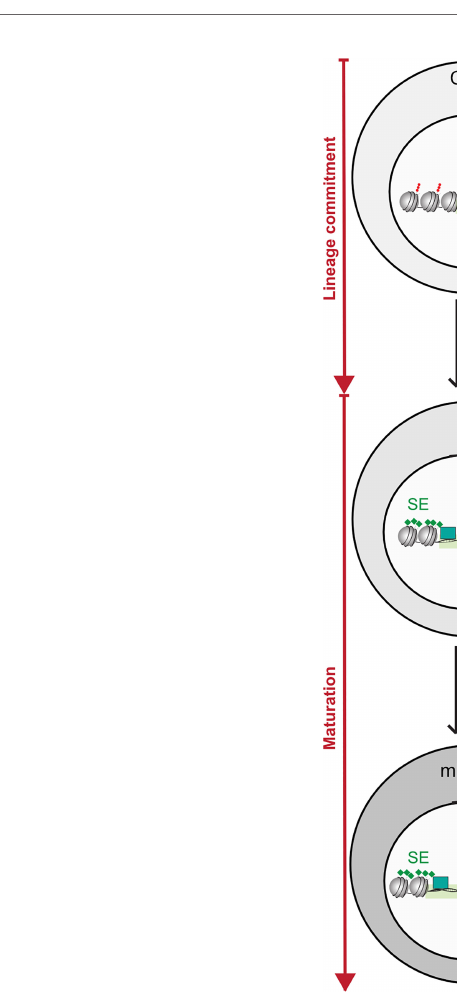
FIGURE 2 | Epigenetic regulation of NK cell lineage commitment and maturation. Lineage commitment: NK cells develop from a common lymphoid progenitor (CLP) in a multistep process, of which several steps are excluded in this schematic. During lineage commitment, NK cells were found to undergo striking changes in chromatin accessibility. Regulatory elements (RE) de fi ned by epigenetic features show a highly dynamic re-organization during lineage-commitment: the stepwise loss of progenitor signature REs on genes like PU.1 is accompanied by the acquisition of NK cell signature REs. Of these, cell-type speci fi c REs are often marked by super enhancers (SEs), which are found on genes crucial to cell identity and functionality. Areas, which display an increase in chromatin accessibility during lineage commitment are often enriched in lineage-de fi ning transcription factor (LDTF) binding sites. Moreover, the lncRNA Rroid, which regulates the NK cell LDTF ID2 was shown to promote both lineage commitment and maturation in NK cells and ILC1. NK cell maturation: During NK cell maturation, further functional specialisation is promoted on an epigenetic level. In human NK cells, terminal maturation is accompanied by an extensive epigenetic remodelling of the Ifng locus, which consisted of consecutive demethylation of the Ifng transcriptional start site (TSS) and the acquisition of the permissive histone mark H3K4me3, both leading to a more effective IFN- g production. IFN- g transcription in mature NK cells is further regulated by the lncRNA Ifng-as1 , which regulates local and distal chromatin interactions with the Ifng